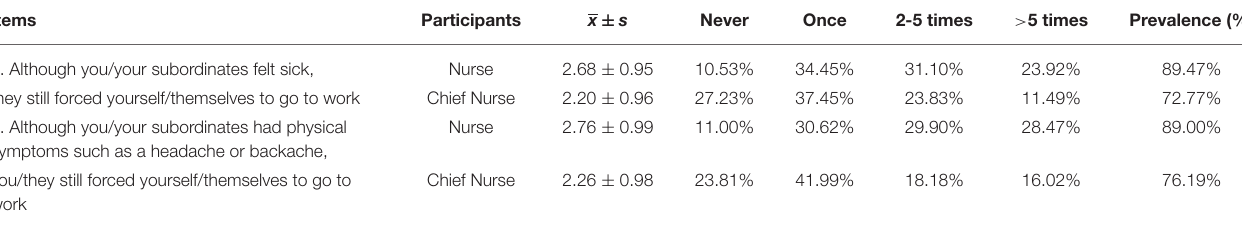
TABLE 1 | The distribution of presenteeism scores (%).